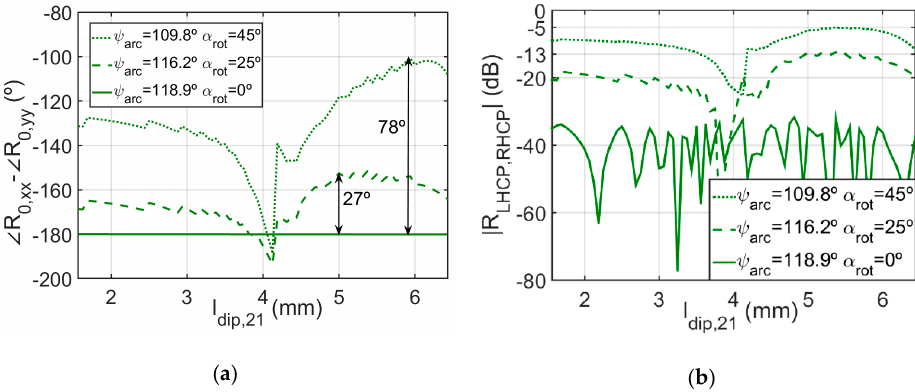
Figure 5. ( a ) Simulated difference between the phases of R 0 ,xx and R 0 ,yy for different values of ψ arc and α rot ( b ) Simulated magnitude of the cross-polar coefficients R LHCP,RHCP for different values of ψ arc and α rot . The results are obtained for the pairs of lengths of dipoles l dip , 21 and l dip , 22 indicated by the black solid lines of Figure 4a at 20 GHz under incidence angles θ i = 19°, ϕ i = 0°.